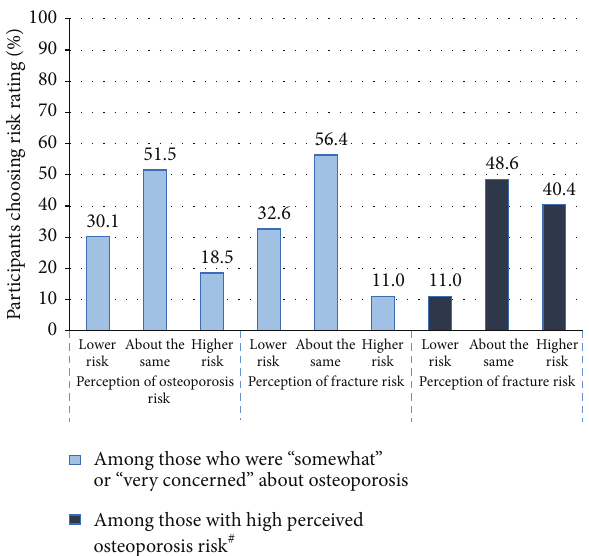
Figure 1: Percentage of risk perception to osteoporosis ∗ and facture ∗ by differing levels of concern about osteoporosis ∧ and risk # . ∗ Risk perception to osteoporosis (how would you rate your own risk of “getting osteoporosis” compared to other women your age?) and risk perception to fracture (how would you rate your own risk of fracturing or breaking a bone compared to other women your age?) were each assessed using 5-point Likert scales (i.e., much lower, a little lower, about the same, a little higher, or much higher) [12]. # For this study: higher risk = “a little higher” or “much higher”. ∧ Concern about osteoporosis (in thinking about your health, how concerned are you about osteoporosis?) was assessed using a 3-point Likert scale (i.e., very concerned, somewhat concerned, and not at all concerned) [12].